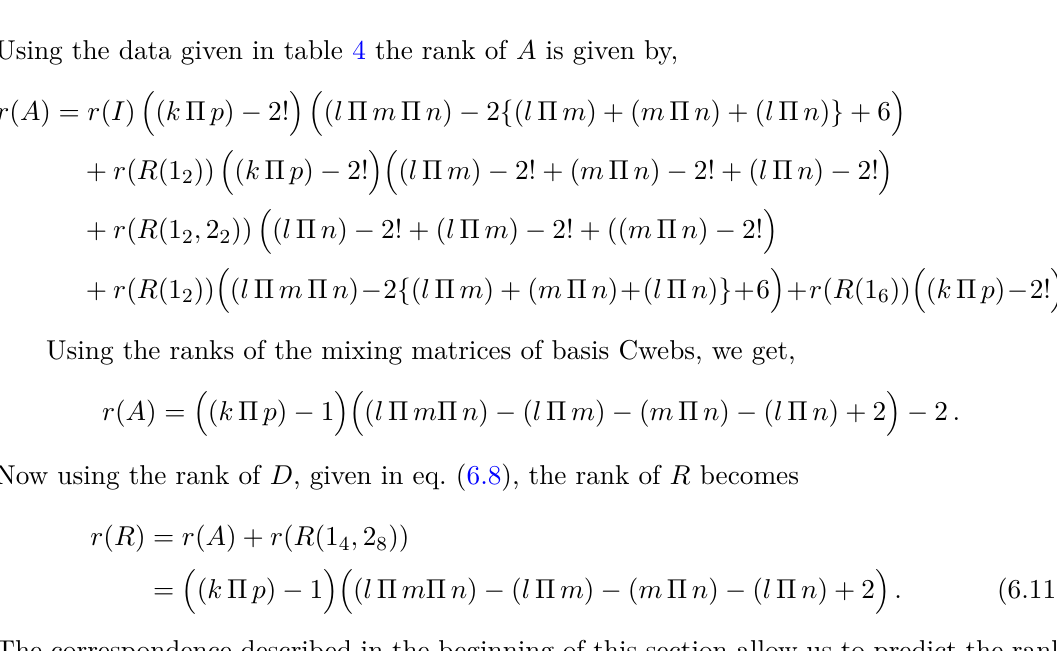
Table 5. Boomerang Cwebs present at four loops and